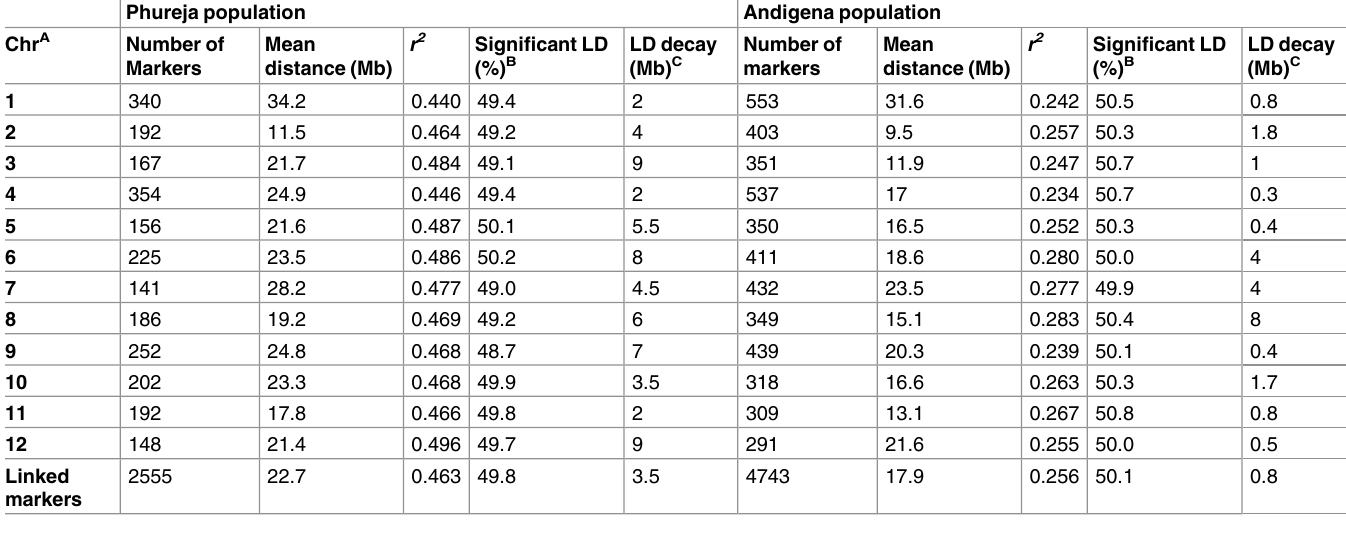
Table 6. Linkage disequilibrium in populations of the Colombian Central Collection of